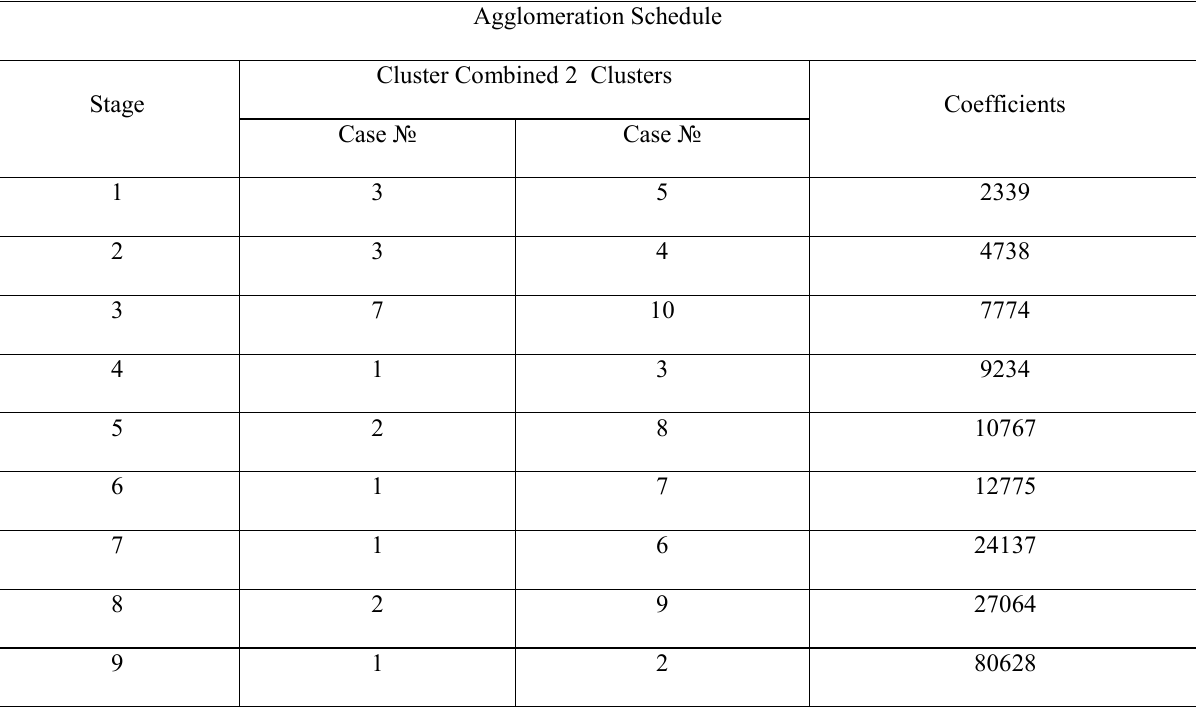
Process of students’ combining in clusters (groups) with the help of cluster analysis by values of heart beats rate (HBR) in situation of fear of heights’ overcoming and by psycho-physiological